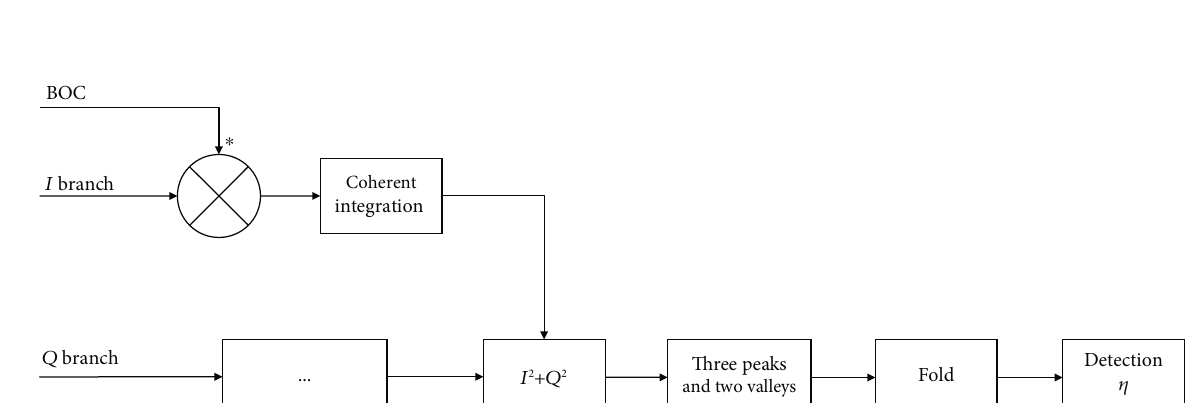
Three peaks FoldDetection 휂 and two valleys 1